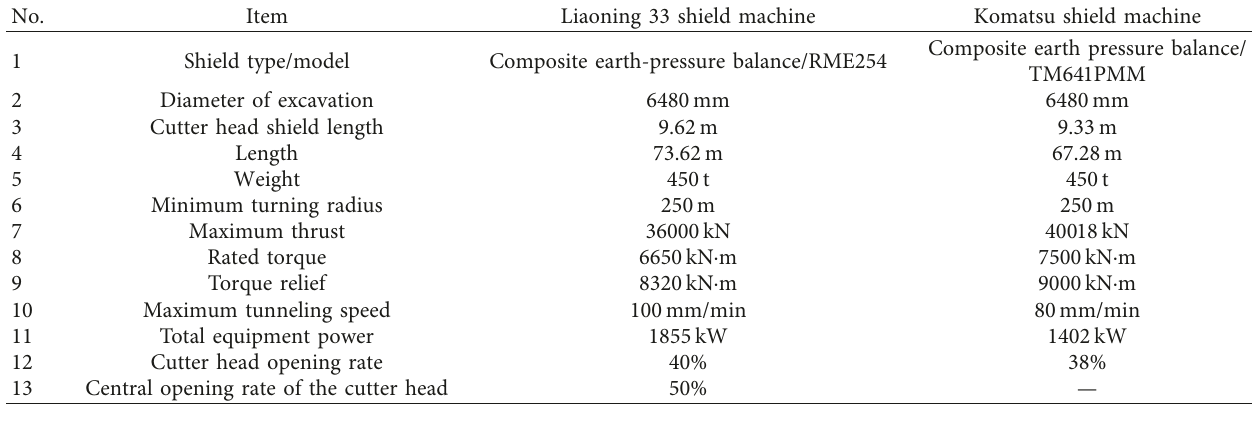
Table 1: Overview of shield machines in the XW section.